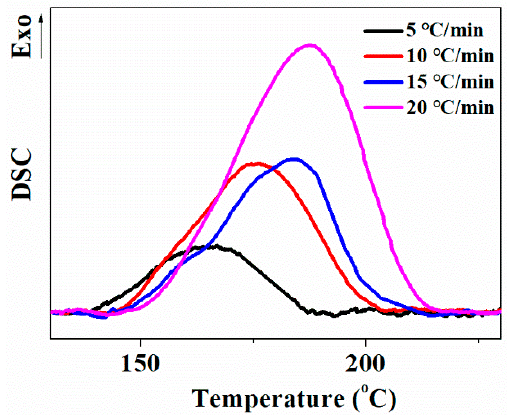
Figure 13. DSC curves of pre-vulcanized silicon rubber after CO 2 treatment with different temperature-rising rates.